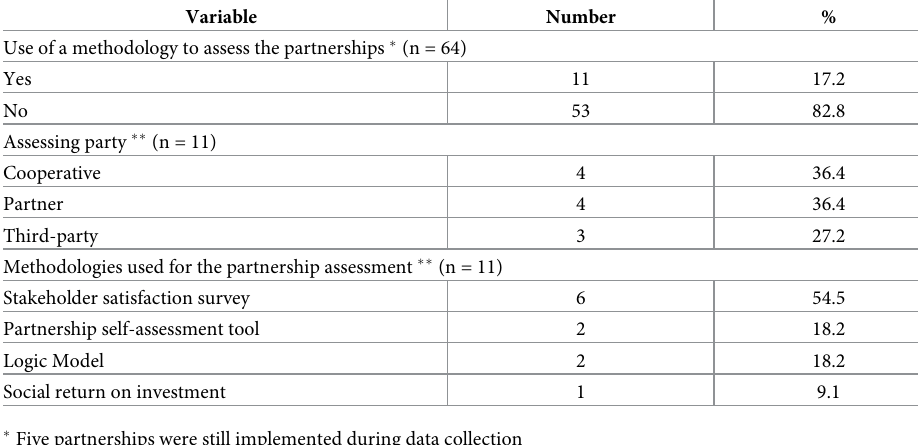
Table 11. Types of methodologies used for the partnership assessment.